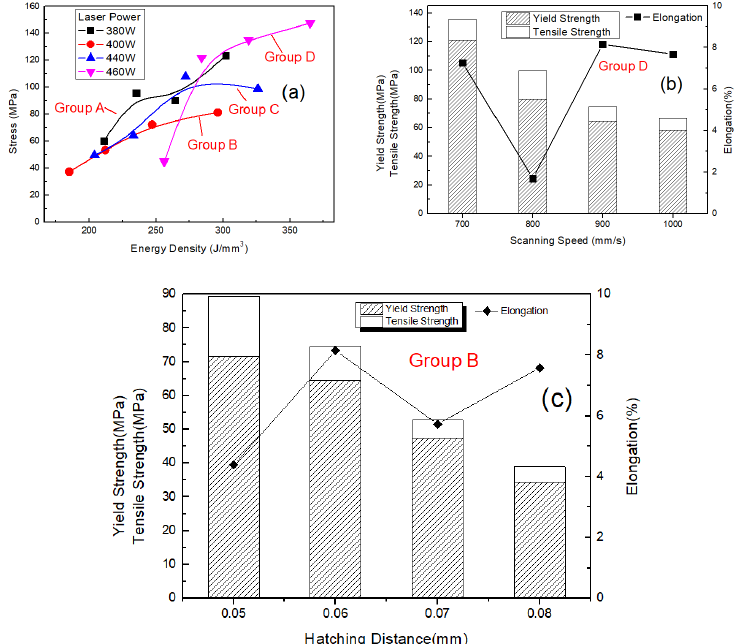
Figure 8. Strength curves of the SLM alloy formed under different process parameters: ( a ) strength of the alloy versus energy density (laser power is labeled according to different groups via different symbols and legends), ( b ) scanning speed versus strength of the alloy and ( c ) hatching distances versus the strength of the alloy.